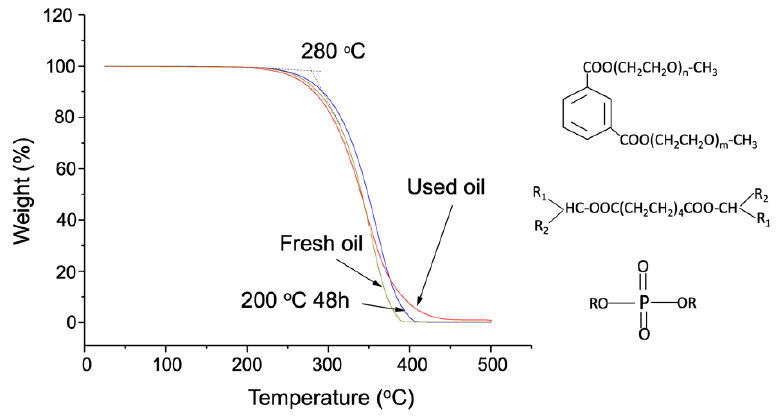
Figure 2. Thermogravimetric analysis of the three aerospace lubricant samples: the 200 °C, 48 h samples were prepared by heating the fresh oil capped in a glass vial, and the used oil was discharged from an aircraft engine system provided by Honeywell.